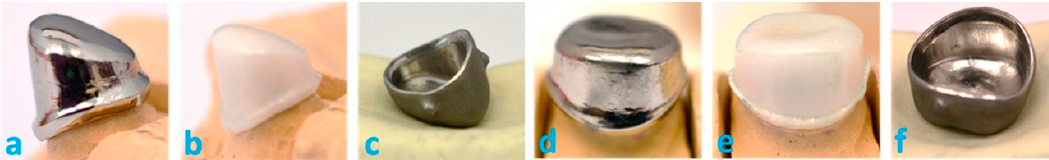
Figure 5. Macroscopic images of the manufactured telescopic system: primary crown made from CoCr ( a ), ZrO 2 ( b ), and secondary crown ( c ) of tooth 1.3 and primary crown made from CoCr ( d ), ZrO 2 ( e ), and secondary crown ( f ) of tooth 2.6.